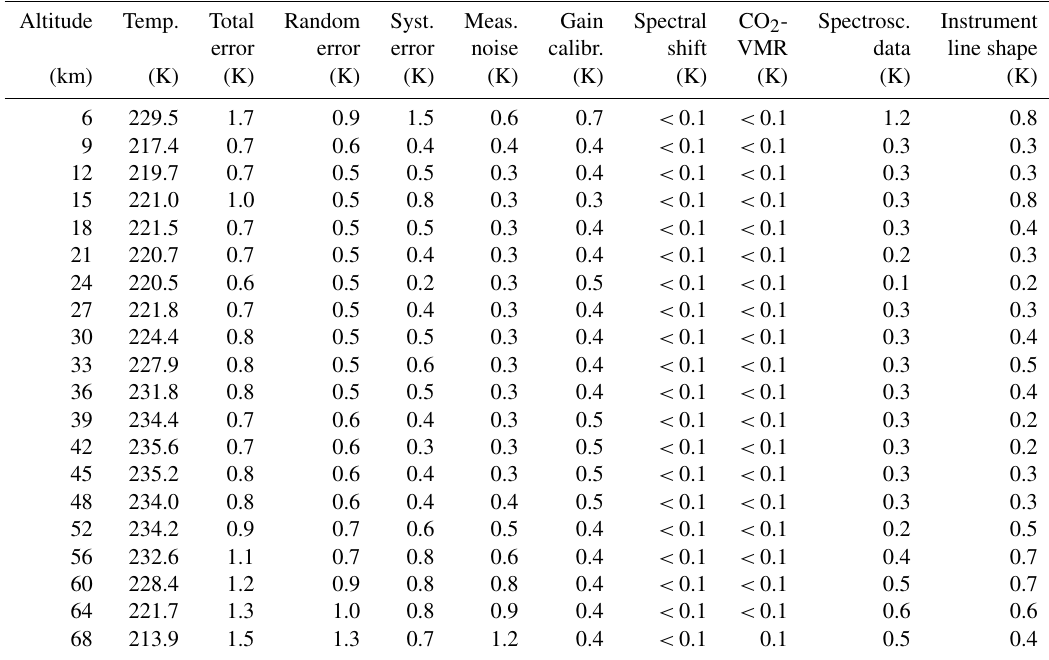
Table A1. RR data temperature error budget for northern polar winter night. All uncertainties are 1 σ . Altitude Temp.